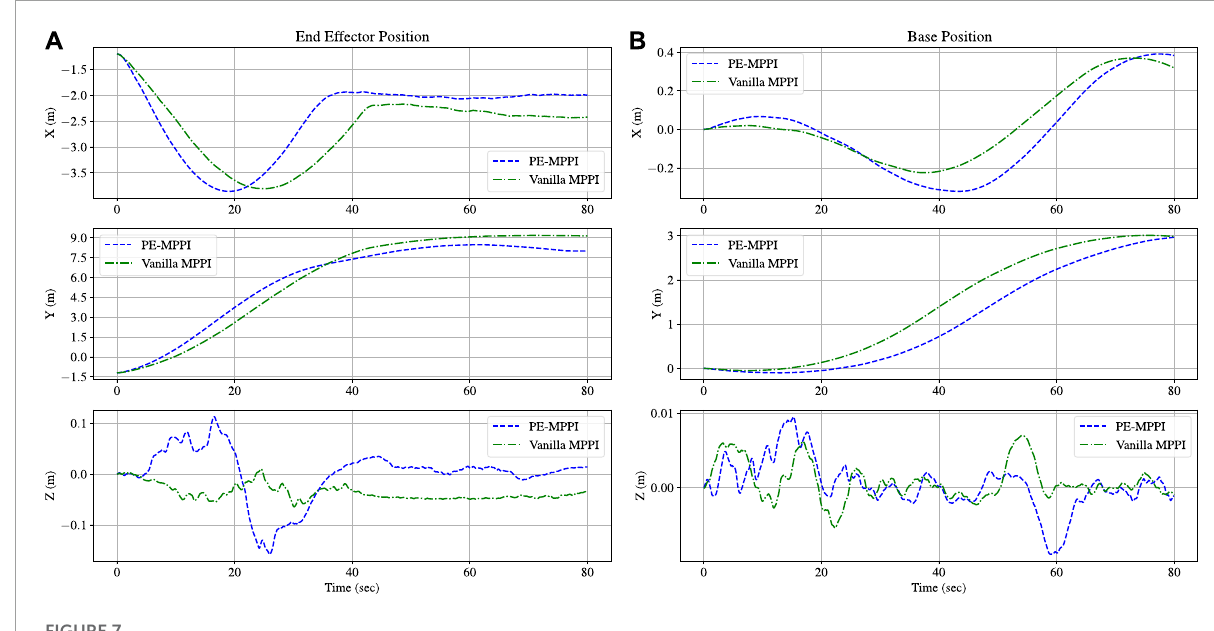
FIGURE 7 Comparison between PE-MPPI and vanilla MPPI in the actuator failure scenario for the end-effector position (A) and the space robot base position (B)